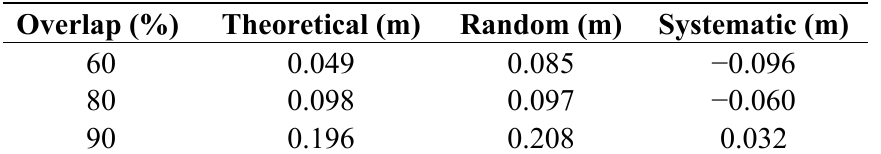
Table 5. Effect of the overlapping percentage in height accuracy of DSMs provided from stereo models with 60%, 80% and 90% stereo overlaps by NGATE.